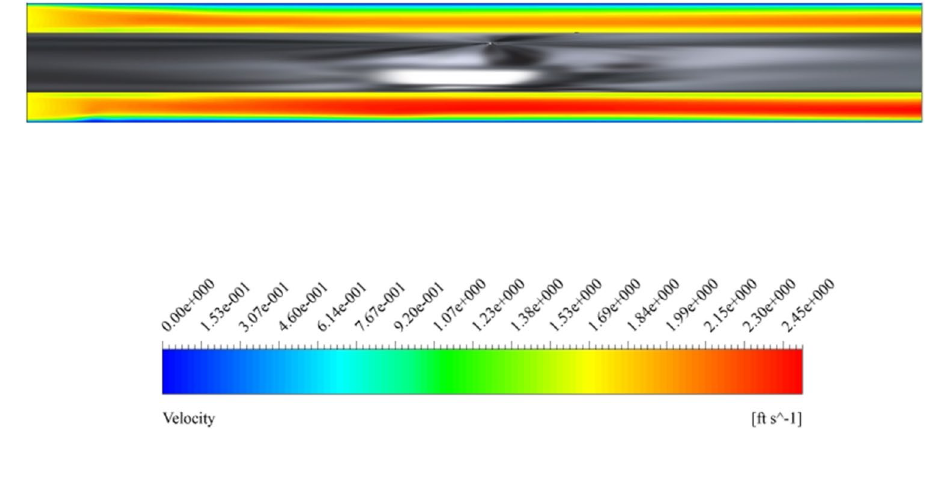
Fig. 10 Velocity vectors in a vertical cross section for a phase velocity of the cuttings, b phase velocity of the drilling